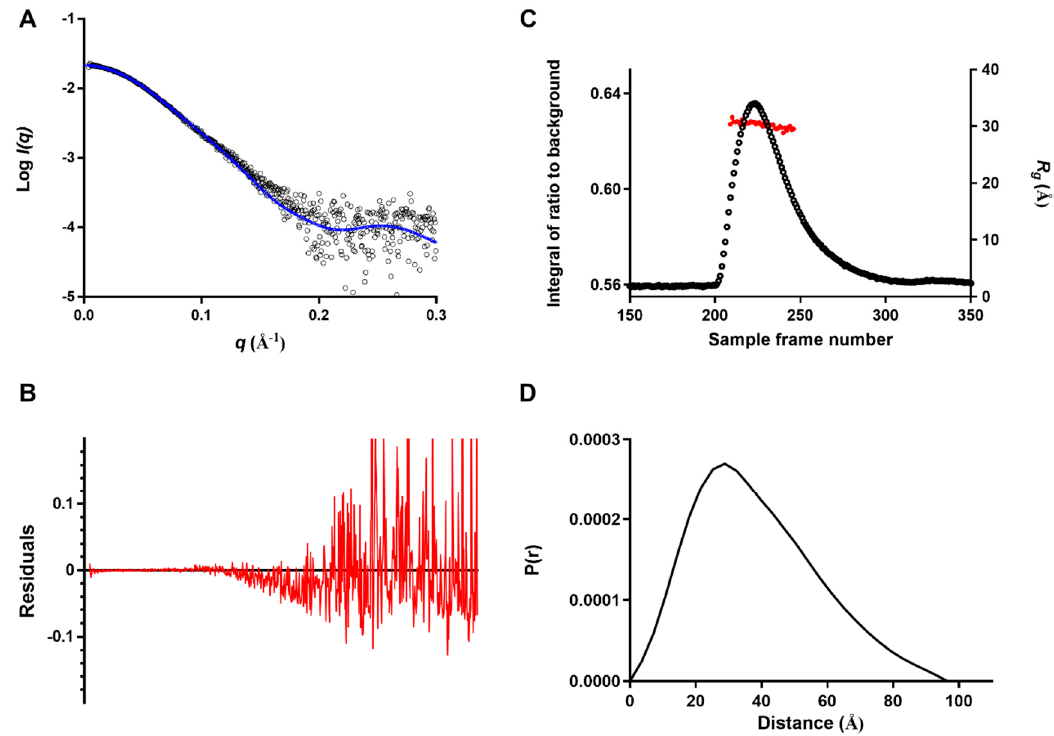
Figure 4. Small-angle X-ray scattering (SAXS) data for the PAI-1/Nb93 complex. ( A ) The averaged scattering curve (black circles) was fitted with the theoretical scattering curve calculated using CRYSOL from the crystal structure of the complex (blue line); ( B ) The residual plot corresponding to the fit is represented by the red curve. ( C ) In total, 480 frames were collected during elution from an Agilent Bio SEC-3, 300 Å, 4.6 × 300 mm column. ScÅtter was used to plot the R g as a red circle scaled on the right axis, the integral of ratio to background is shown as a black circle and scaled on the left axis. ( D ) The pair distribution function P(r) was solved using ScÅtter incorporating the averaged scattering curve data up to q = 0.29 Å − 1 .